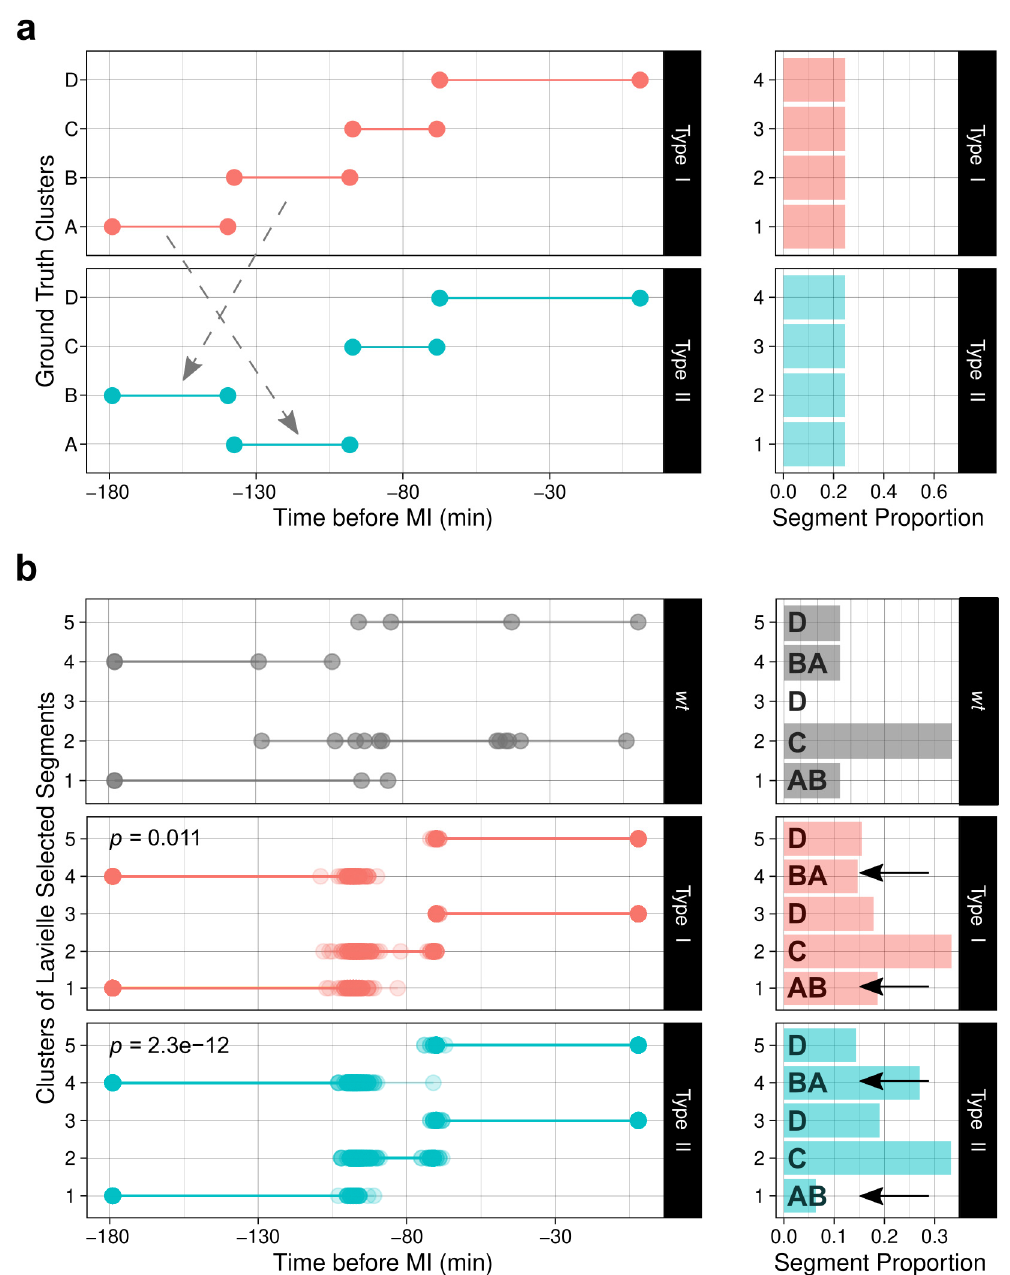
Figure 3. Segmentation of wt and synthetic chromosome movement datasets. The 6 wt tracks and 200 simulations of 180 samples each were used throughout this analysis: ( a ) On the left, segment-plot of the ground-truth segmentation for the simulated time-series. On the right, presence proportion of each segment in the dataset. ( b ) On the left, segment-plot of a proposed segmentation after segclust2d ’s algorithm with Lavielle’s criterion selection: from top to bottom, experimental wt CM data, Type I and II synthetic tracks. Reported p -values (top left of each segment-plot) for the ANOVA after Logistic Regression (LR). LR models in the comparison are the interaction between cluster type and duration, and the intercept-only model, between the baseline case ( wt ) and the two synthetic datasets. On the right, relative count of cluster presence across the datasets. Time scales are adjusted w.r.t. the beginning of MI.